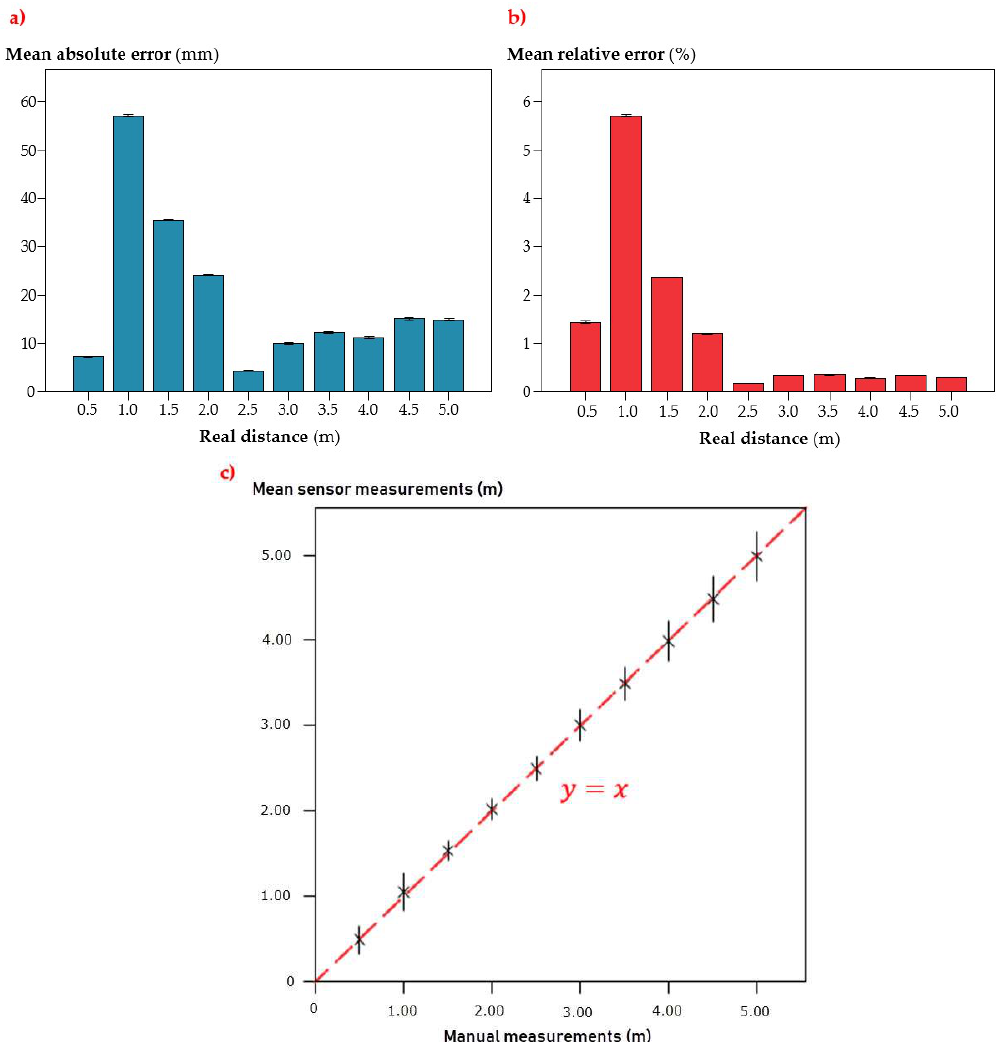
Figure 8. Sensor measurement ( a ) absolute and ( b ) relative mean error. Error bars represent the Standard Error ( c ) Comparison between manual and sensor-collected measurements in the accuracy test. Error bars represent 1000 (10 3 ) fold Standard Error.